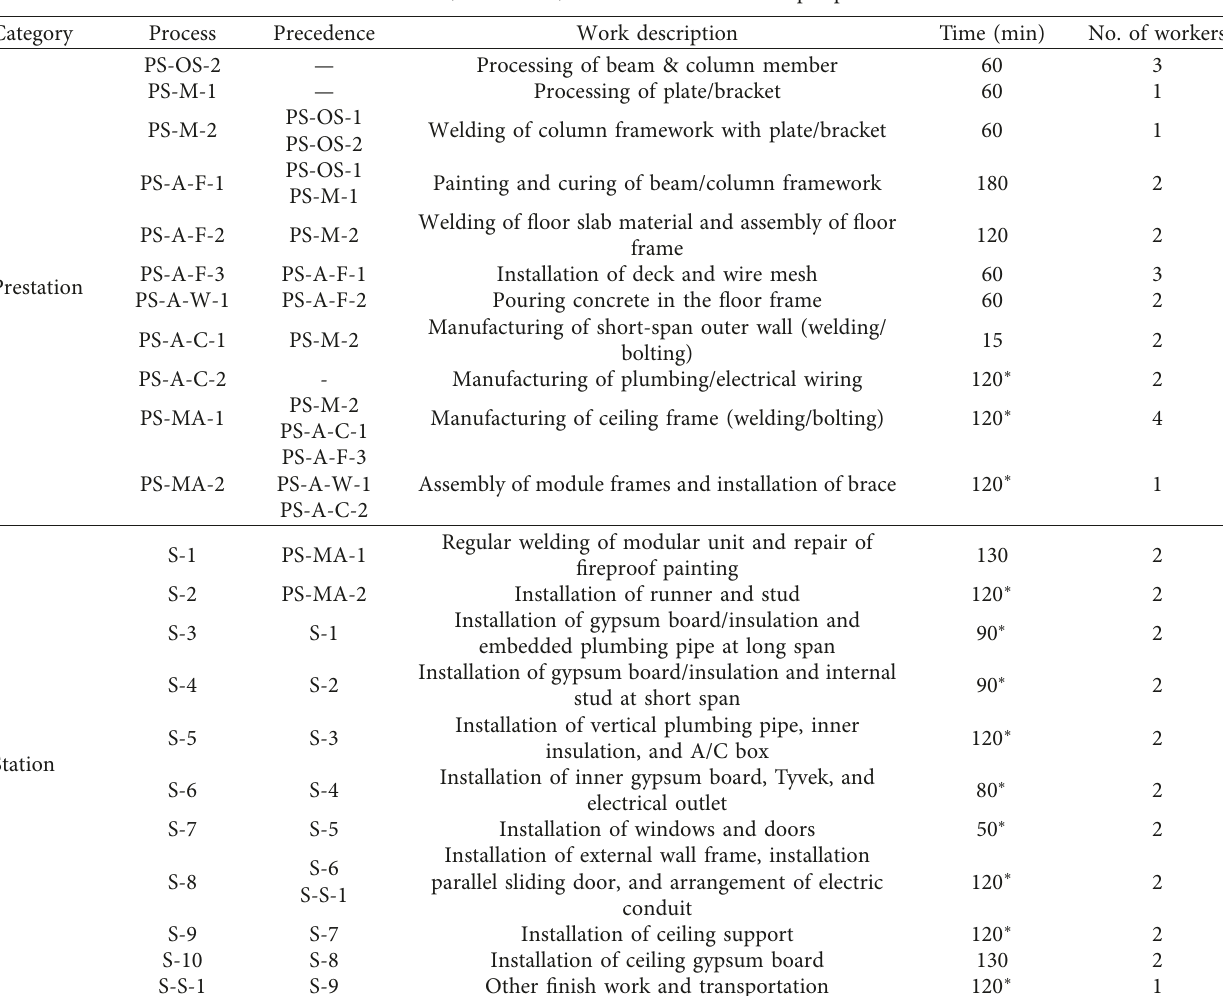
Figure 3: Subdivided manufacturing process flow. Table 1: Work, work time, and number of workers per